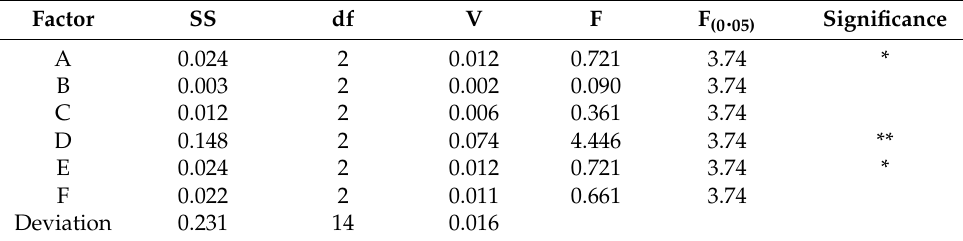
Table 6. Variance analysis of the PTS.